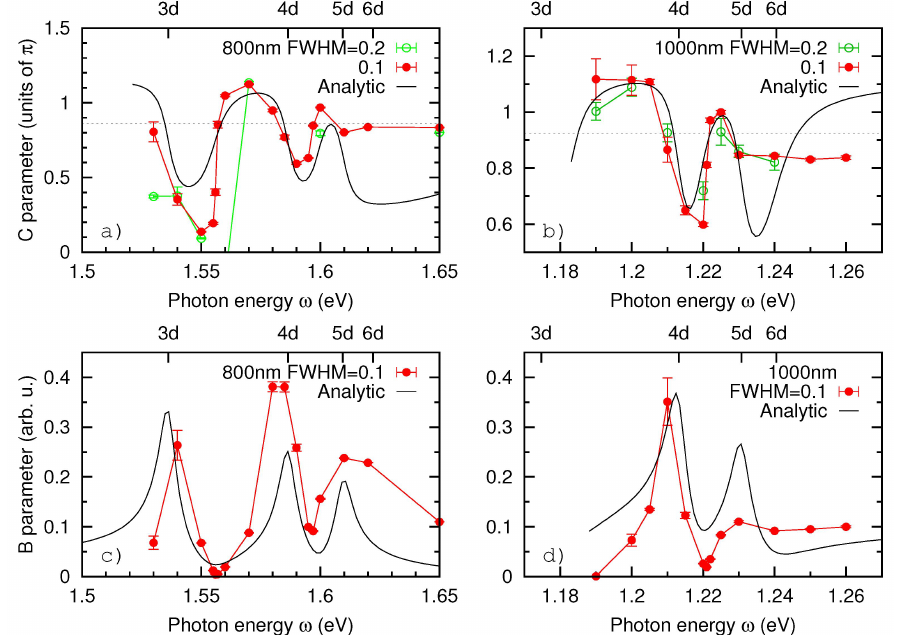
Figure 5. Top: the RABBITT phase C parameter as the function of the fundamental laser frequency in the 800 nm ( a ) and 1000 nm ( b ) wavelength ranges. The top horizontal axis marks the crossing of the harmonic peaks H13 ( a ) and H17 ( b ) with the discrete nd energy levels. Bottom: the RABBITT magnitude B parameter for the 800 nm ( c ) and 1000 nm ( d ) spectral ranges. Comparison with the analytic expressions (6) and (7) is made. The thin dotted line marks the non-resonant RABBITT C parameters which remain flat over the marked photon energy